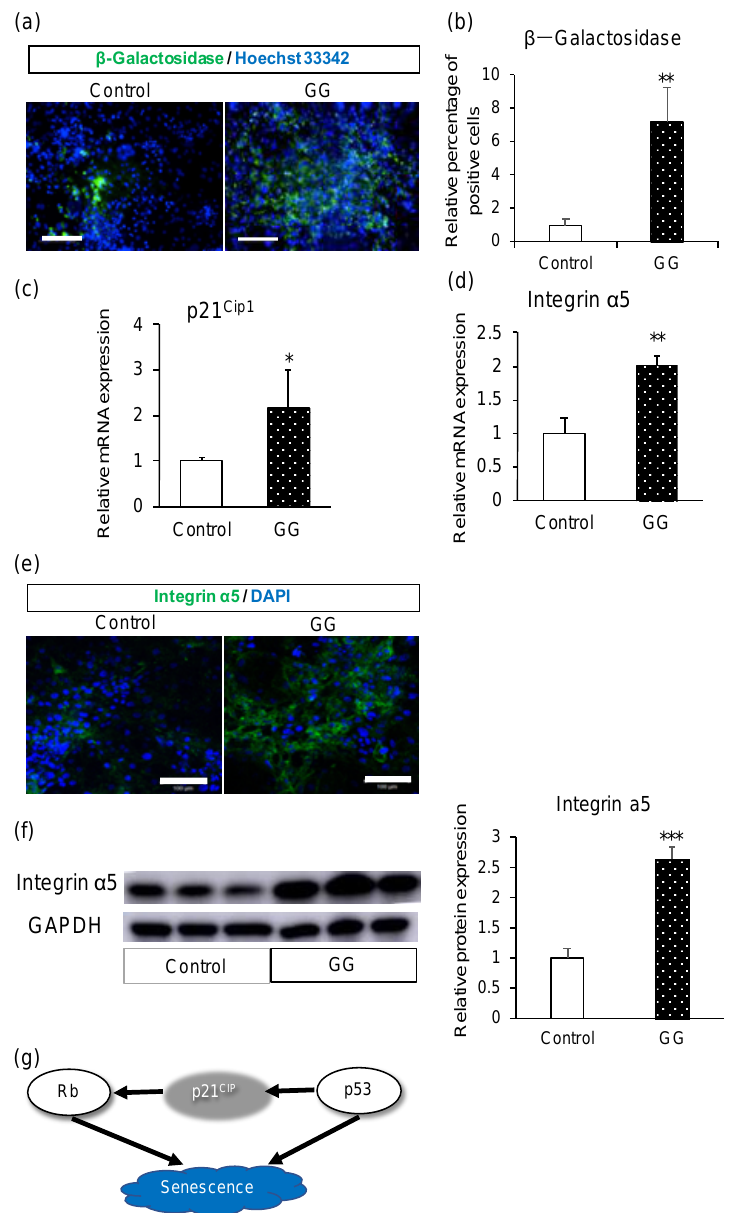
Figure 4. Mechanistic analysis of the e ff ect of GG in enterocyte di ff erentiation. ( a ) Immunofluorescence images of the senescence marker β -galactosidase. ( b ) Relative percentage of β -galactosidase-positive cells. ( c ) Relative mRNA expression levels of p21 Cip1 . ( d ) Relative mRNA expression levels of integrin α 5. ( e ) Immunofluorescence images of integrin α 5. ( f ) Western blotting analysis of integrin α 5 and relative protein expression. ( g ) Proposed scheme showing the relationship between p21 Cip1 and senescence. Scale bars = 100 µ m. All data are presented as mean ± S.D. ( n = 3). Control = 1. Levels of statistical significance compared with the control group: * p < 0.05, ** p < 0.01, *** p <